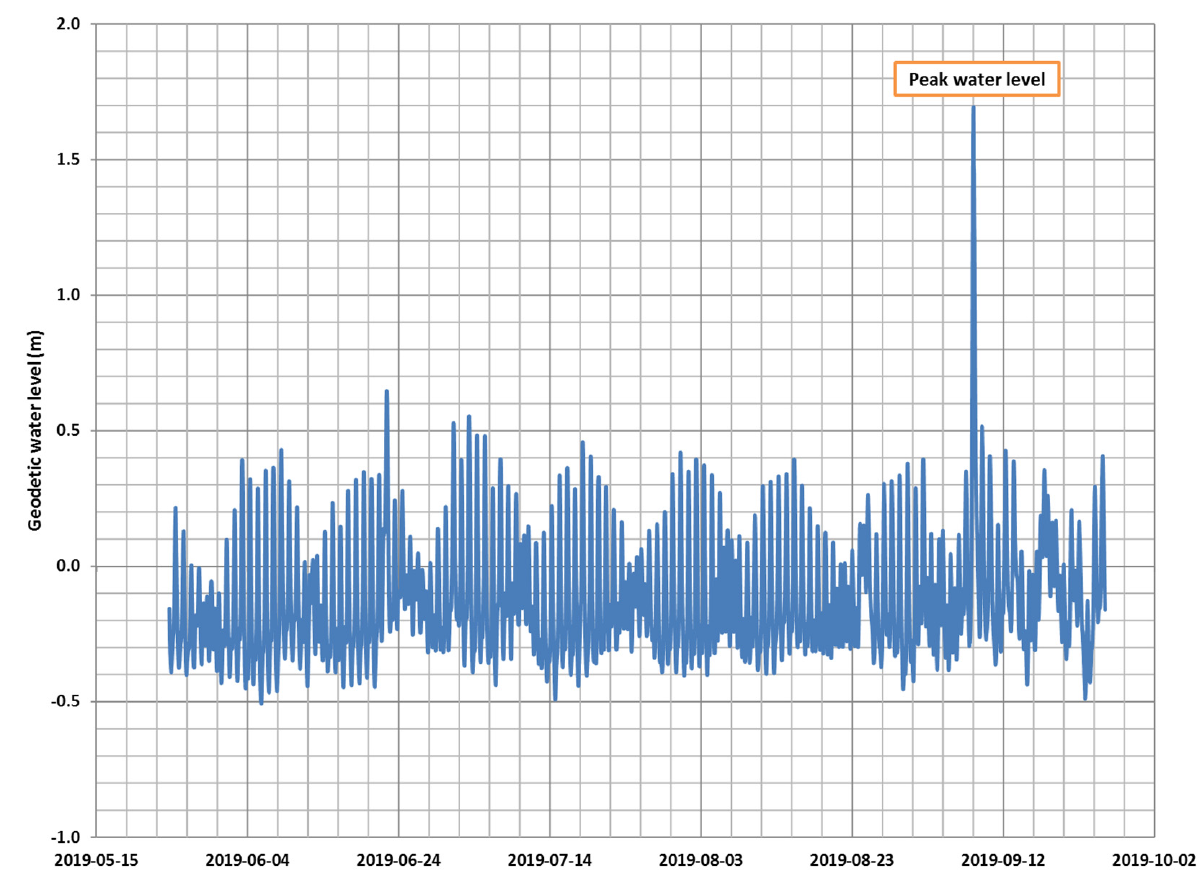
ter level from the most recent high-water event on 21 December 2010. level from the most recent high-water event on 21 December 2010.